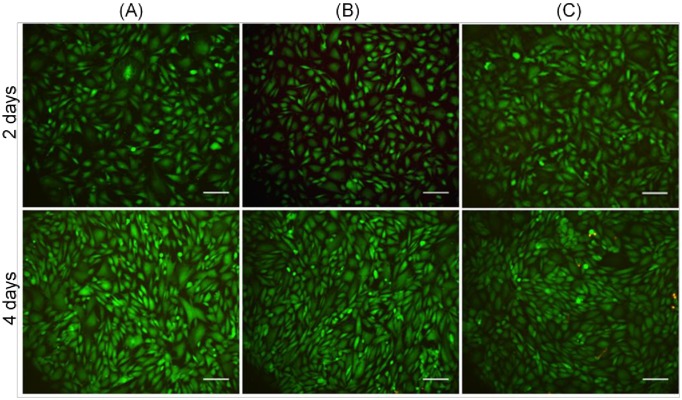
Fluorescent LIVE/DEAD images of BAECs after exposure to hydrostatic pressure for either 2 days or 4 days.Cells were depressurized by either rapid depressurization (A) or slow depressurization (B) or exposed only to ambient atmospheric pressure (negative control) (C) and then stained as in Fig 2. The vast majority of observed cells were live as indicated by the green stain. Scale Bar = 100 μm.